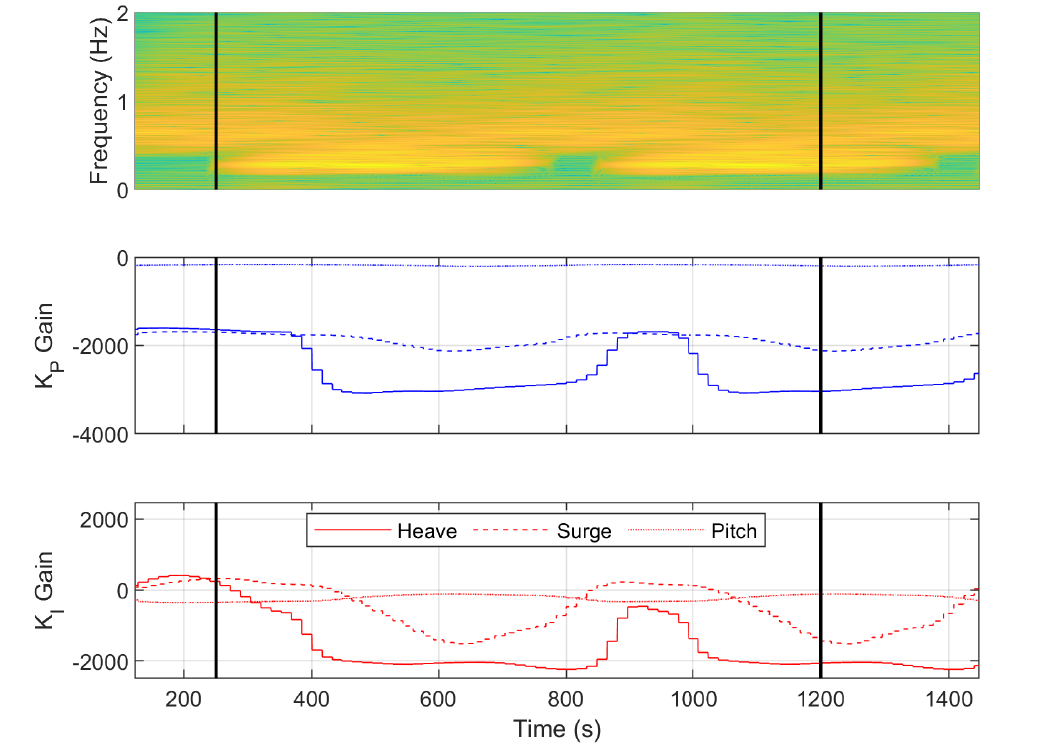
Fig. 8: Self-tuning controller gains for changing 2A-10A wave state. Heave, surge, and pitch line styles are consistent across subplots.